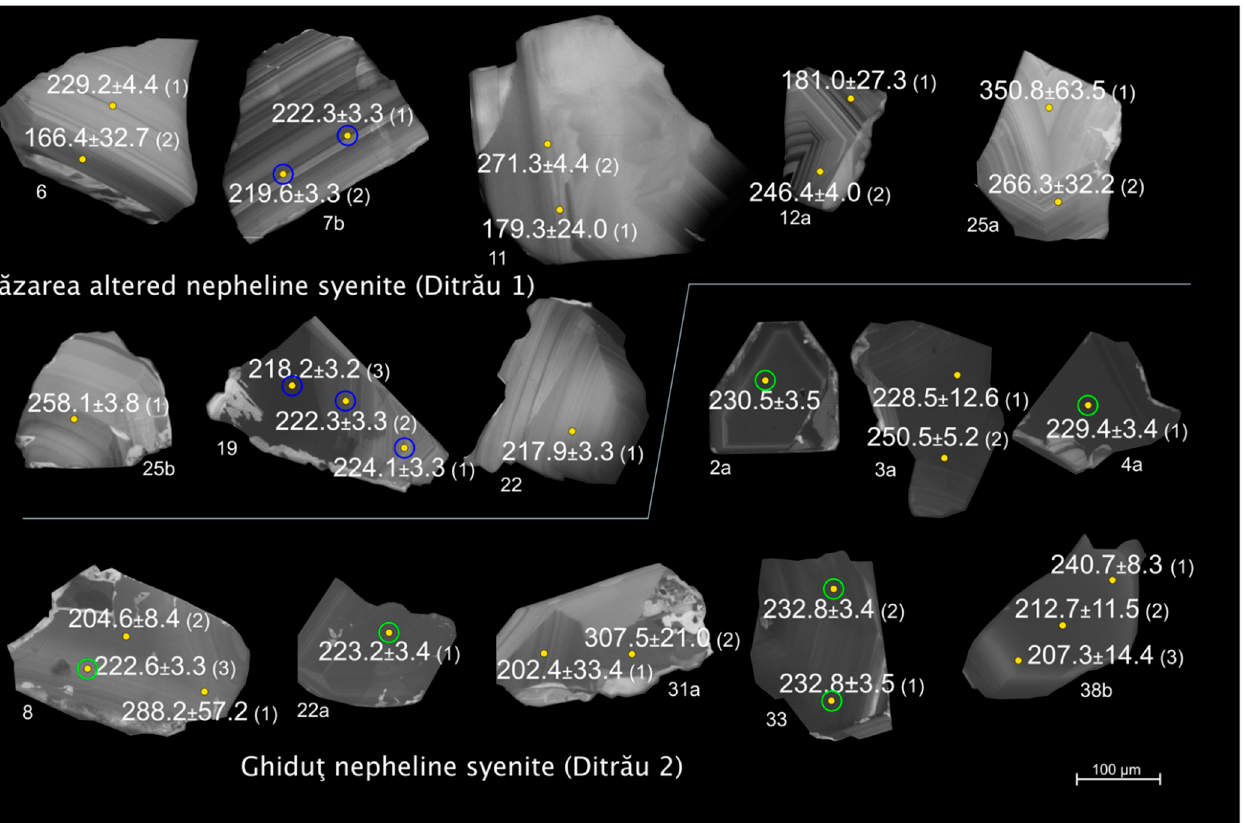
Figure 5. Zircon CL images with SIMS spots indicated as yellow dots (true size 5 × 7 µm). Zircon labels refer to the numbering in Table 2. Numbers in brackets refer to the spot numbers on the individual crystals. Ages are 238 U/ 206 Pb ages ± 2 standard deviations. The spots circled in blue ( 238 U/ 206 Pb > 25 and Th/U > 15, CL-dark domains, weakly visible oscillatory zonation) and green ( 238 U/ 206 Pb > 25 and Th/U < 5, intermediate bright CL domains, well-developed oscillatory zonation) correspond to the spots used to calculate the igneous zircon growth ages (see Figure 7).